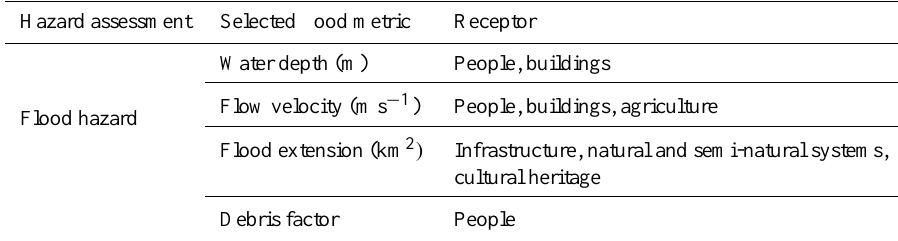
Table 2. Flood metrics to assess hazard for different receptors.